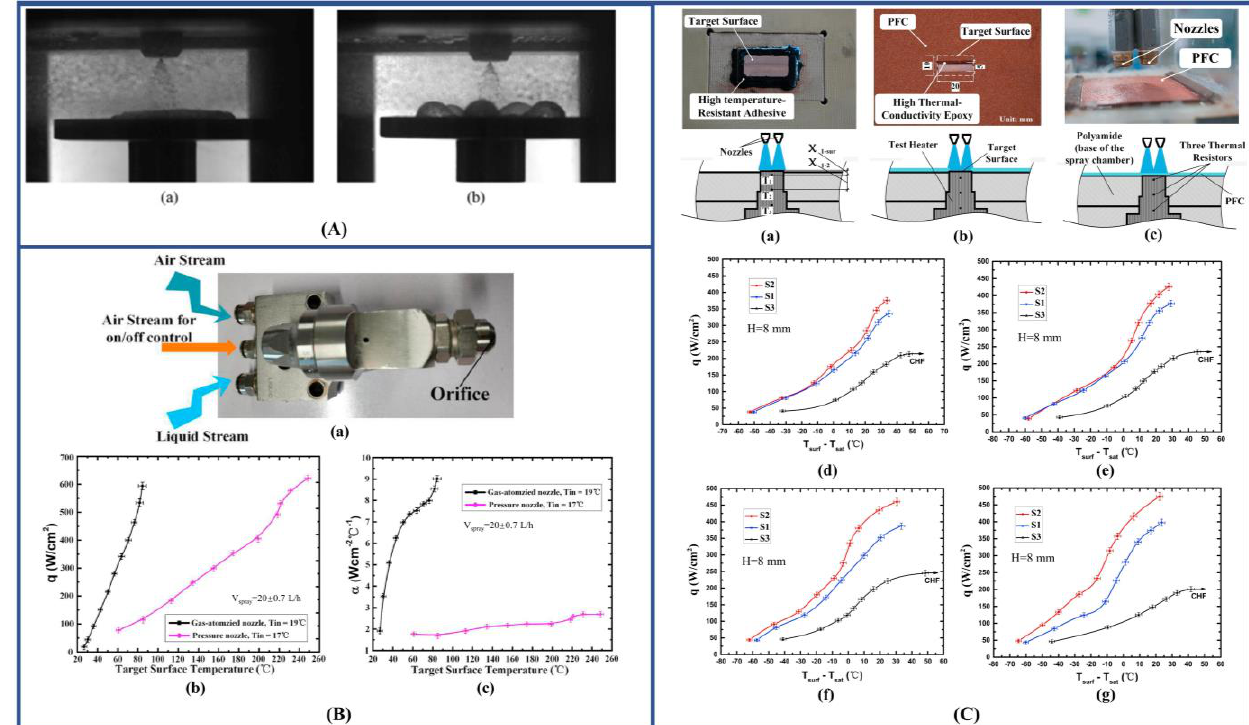
Figure 10. Performance analysis and research on aerospace-oriented spray cooling. ( A ): Visual comparison between normal gravity spray cooling and microgravity spray cooling; gravity spray cooling ( a ); micro-gravity spray cooling ( b ) [155]. ( B ): Photographic view of a gas-atomizing nozzle ( a ); comparison of heat transfer between spray cooling performance of two nozzles, the relationship between heat flux and TST ( b ); HTC and TST ( c ) [59]. ( C ): Three different surface treatment methods, ( a ) S 1 , ( b ) S 2 , ( c ) S 3 ; the experimental characteristic heat transfer curves of different mass flow rates